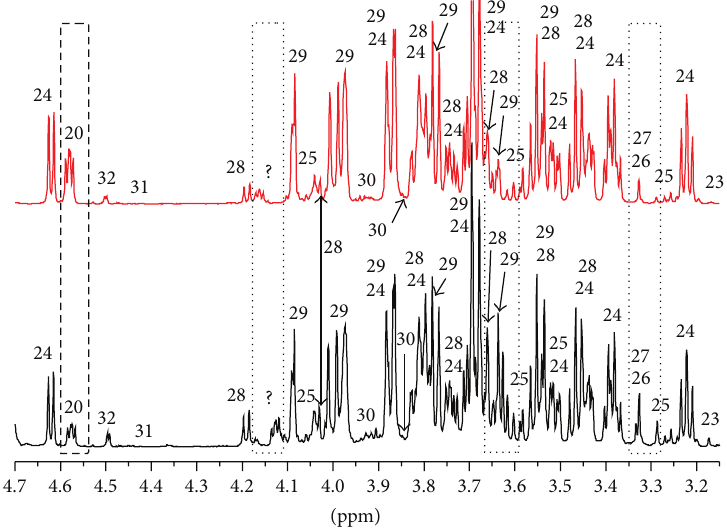
Figure 5: Comparison between the one-dimensional proton spectra of the lemon juice from PGI Interdonato lemon of Messina (red line) and Interdonato Turkish lemon (black line) in the region of the sugars. 20: malic acid, 23: choline, 24: glucose, 25: myoinositol, 26: scyllo-inositol, 27: methanol, 28: sucrose, 29: fructose, 30: serine, 31: trigonelline, and 32: ascorbic acid.